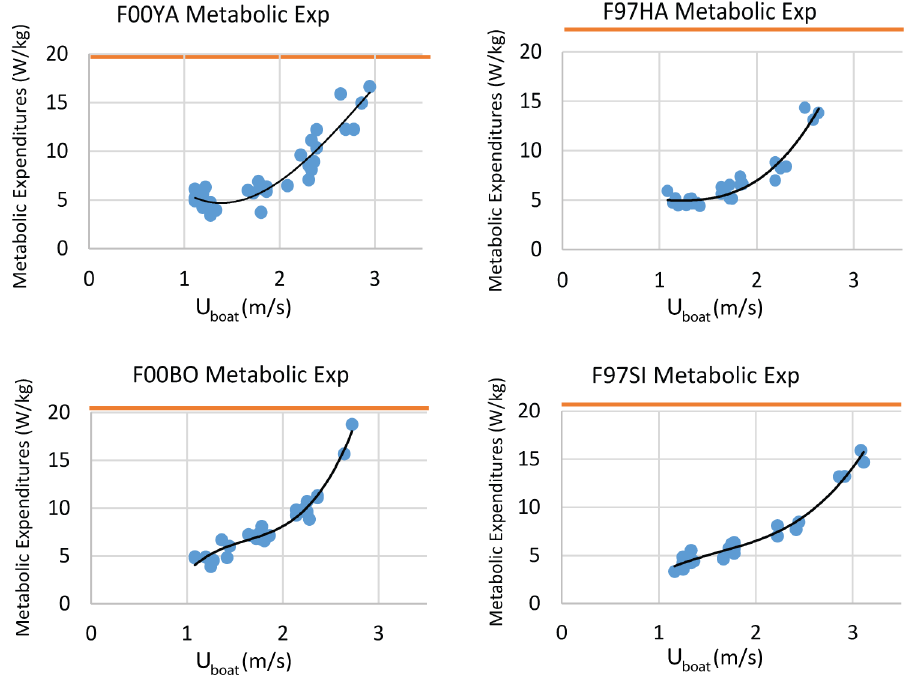
Fig 15. Total Metabolic Expenditures during one complete stroke-glide cycle (mass-specific) as a function of swimming speed. The estimated maximum metabolic rate is for terrestrial mammals [34] and is indicated by the orange